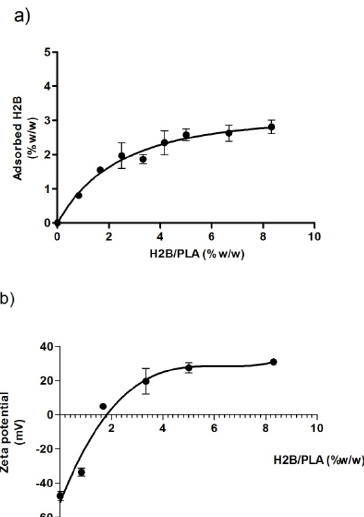
Figure 3. Adsorption curves of H2B/PLA-NPs. ( a ) Adsorption efficiency of the peptide/particles (0.06% w / v ) at different protein-to-particle ratios. ( b ) Zeta potentials of H2B/PLA as a function of initial protein amount (% w / w ).